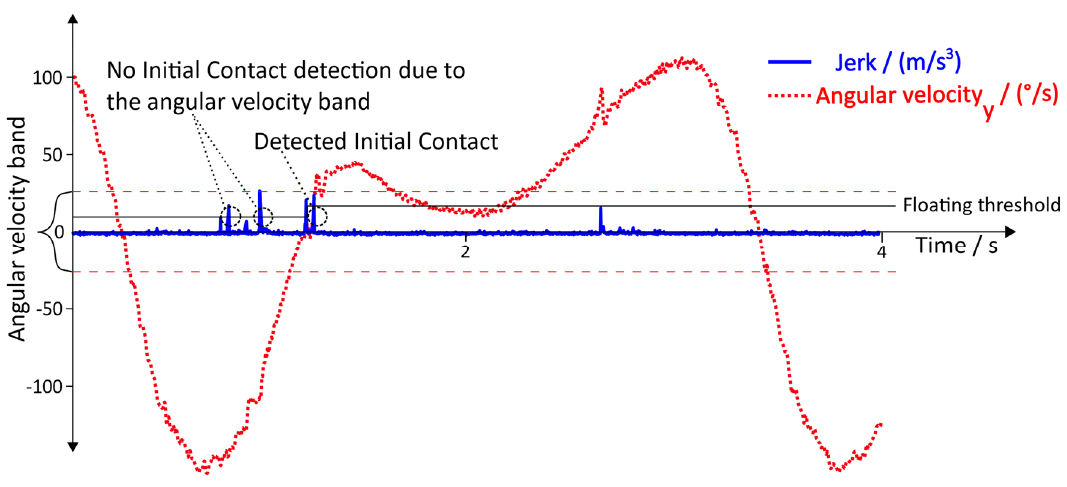
Table 1. Timing of stimulation, adapted from [25]